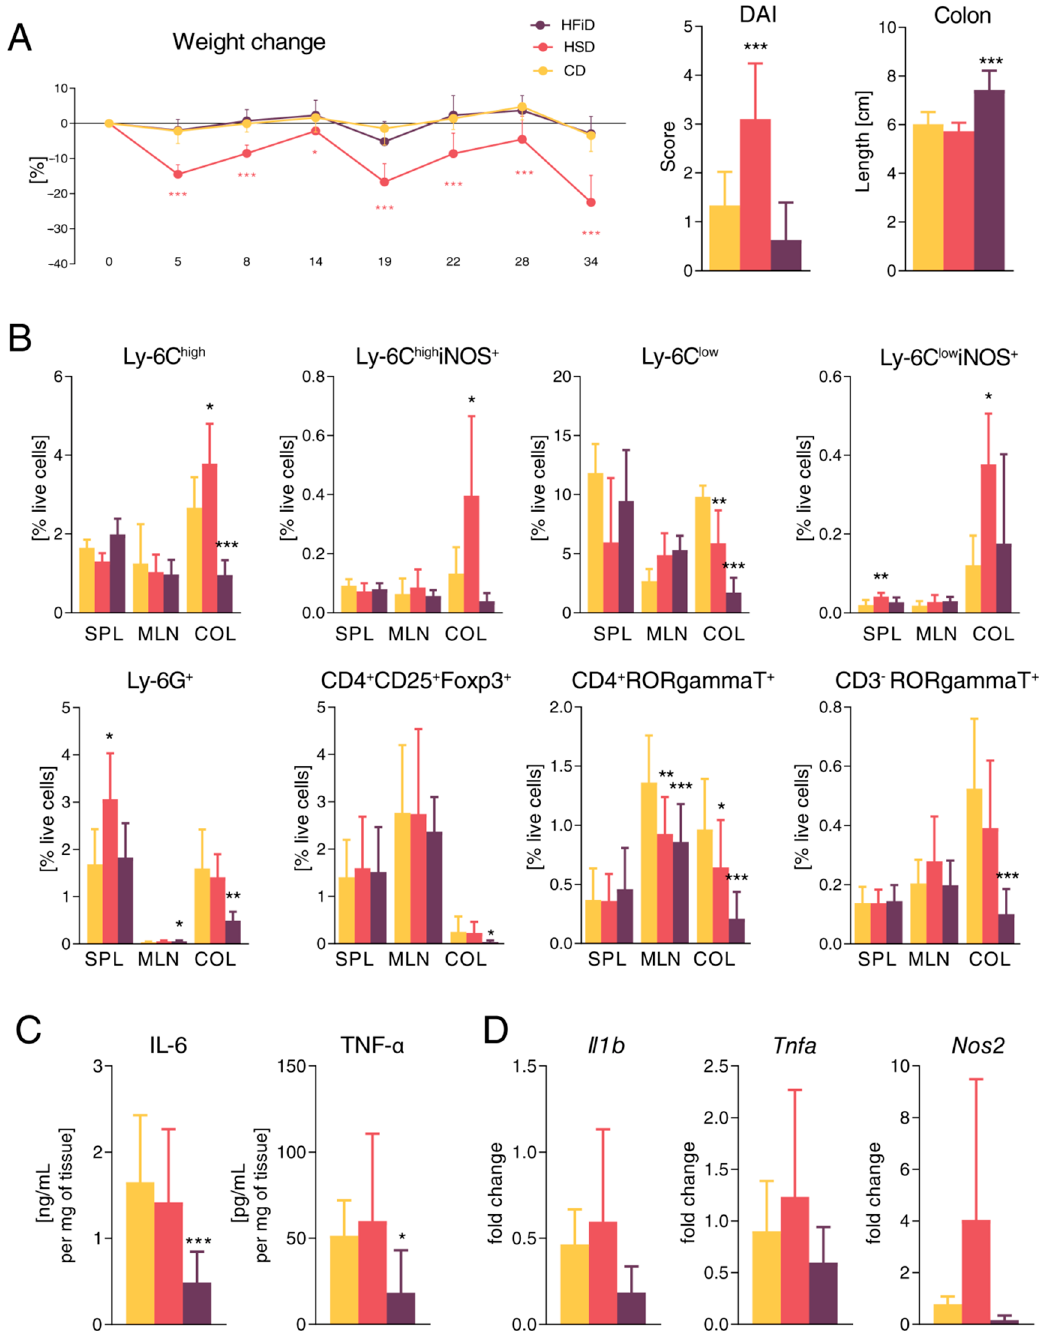
Figure 4. HSD significantly increases the severity of chronic colitis. ( A ) Weight loss, disease activity score, (DAI) and colon length. ( B ) Percentage of live cells from spleens, mesenteric lymph nodes, and colons measured by flow cytometry. ( C ) Cytokines measured in tissue culture of colon biopsies from diseased mice. ( D ) The mRNA expression of pro-inflammatory cytokines and Nos2 in colon. Data presented are from one representative experiment out of two, n = 8 mice per group. Means significantly different from CD were calculated. The weight loss was analyzed by two-way ANOVA with Bonferroni post hoc test and other parameters by one-way ANOVA with Dunnett’s multiple comparison test in a respective organ. Data are shown as mean ± SD. * p < 0.05; ** p < 0.01; *** p < 0.001. CD, control diet; HSD, diet rich in simple carbohydrates; HFiD, diet rich in fiber; SPL, spleen; MLN, mesenteric lymph nodes; COL, colon.